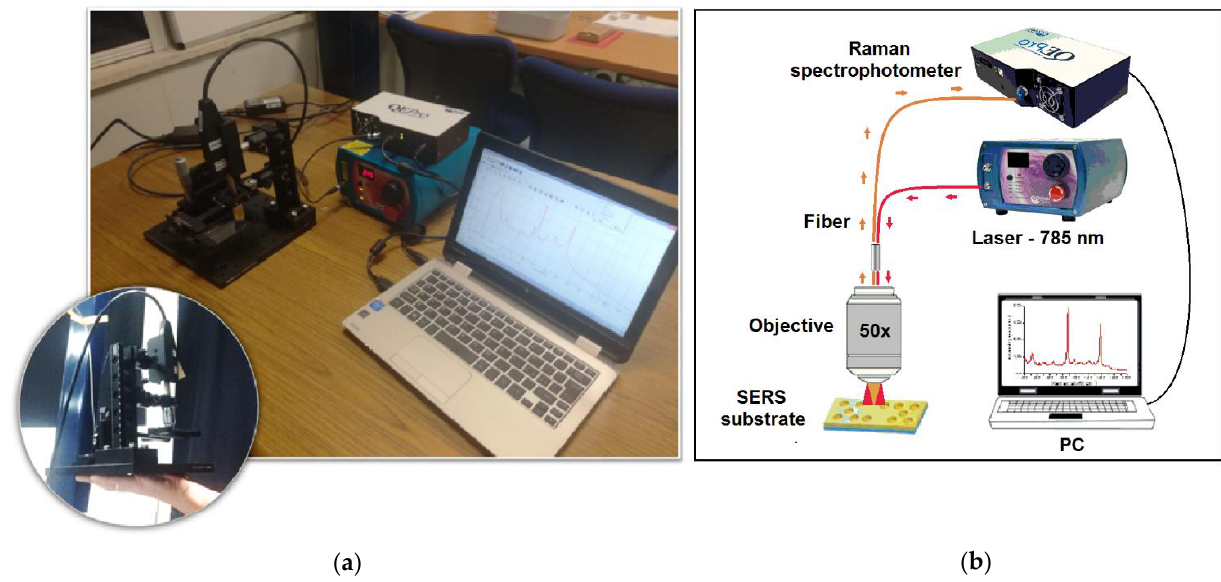
Figure 1. Home-made portable system for Surface Enhanced Raman Spectroscopy (SERS) analysis in situ: ( a ) Picture of the system, ( b ) schematic representation.